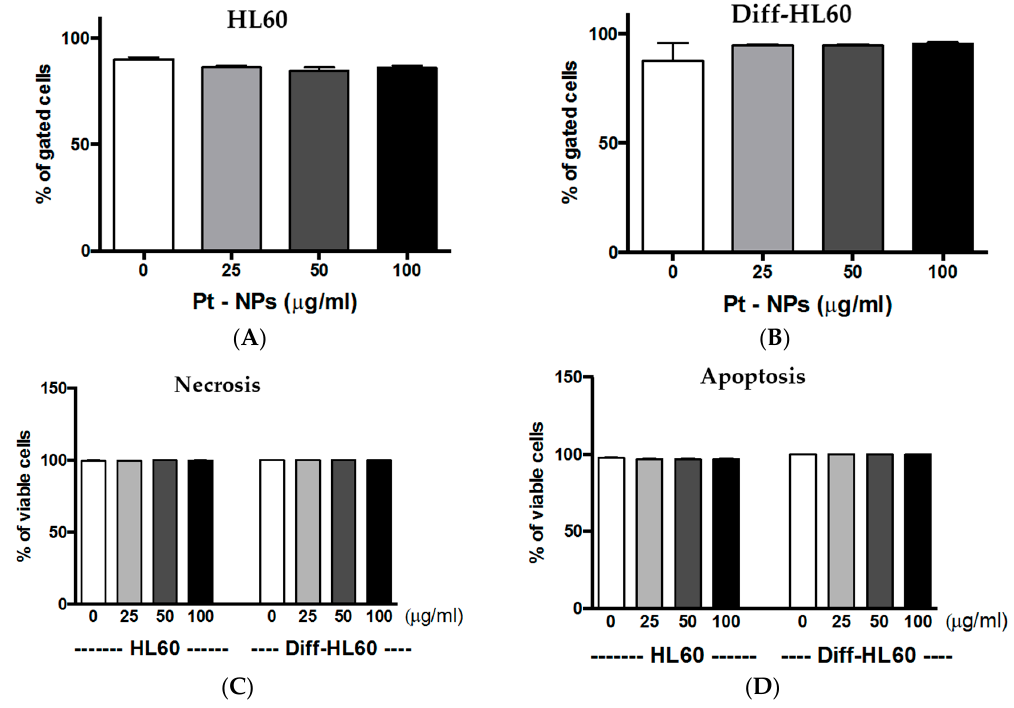
Figure 6. ( A , B ) The bar graphs show the percentages of living undifferentiated ( A ) and differentiated ( B ) cells after 6 h incubation with 25, 50 and 100 μ g/mL 5 nm-PtNPs. ( C , D ) AnnV/PI assay by flow cytometry. ( C , D ) Bars show necrosis ( C ) and apoptosis ( D ) of undifferentiated and differentiated HL60 cells, untreated or treated with PtNPs at different concentrations for 6 h. All the data represent the mean ± SD of three independent experiments.